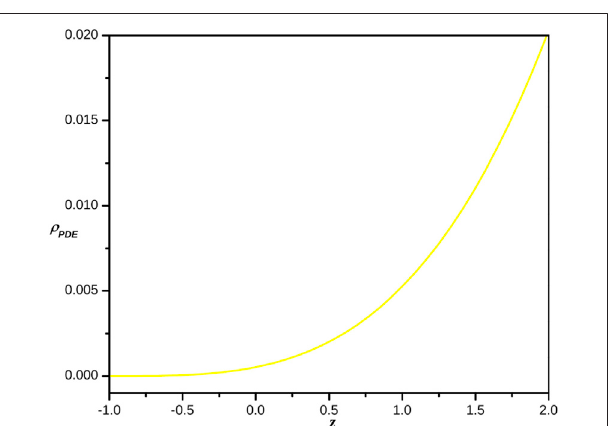
FIGURE 9 | Plot of reconstructed pilgrim dark energy f ( Q ) gravity model versus non-metricity parameter for the appropriate choice of constants c 2 = 0.0018 and c 3 = 0.1.